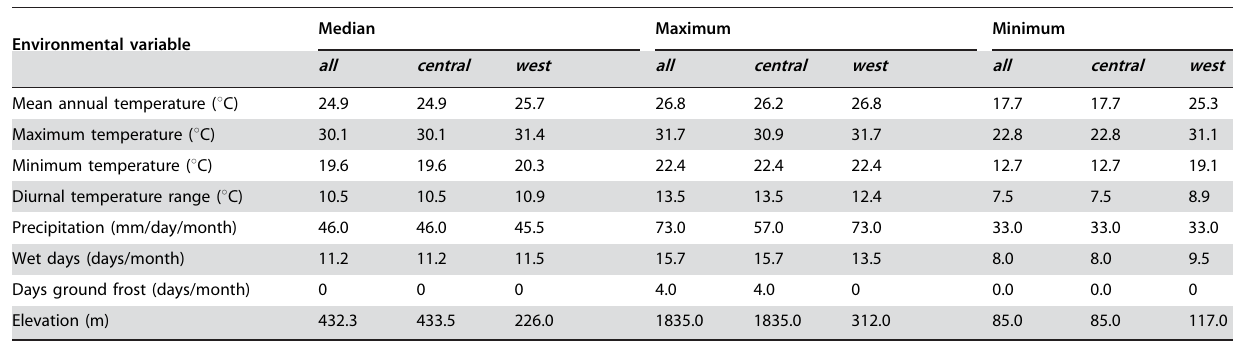
Table 2. Values for climatic environmental variables at 156 geo-referenced points of human monkeypox occurrences. .. ... .... ... ... .... ... ... .... ... ... .... ... ... .... ... ... .... ... ... .... ... ... .... ... ... .... ... ... .... ... ... .... ... ... .... ... ... .... ... ... .... ... ...